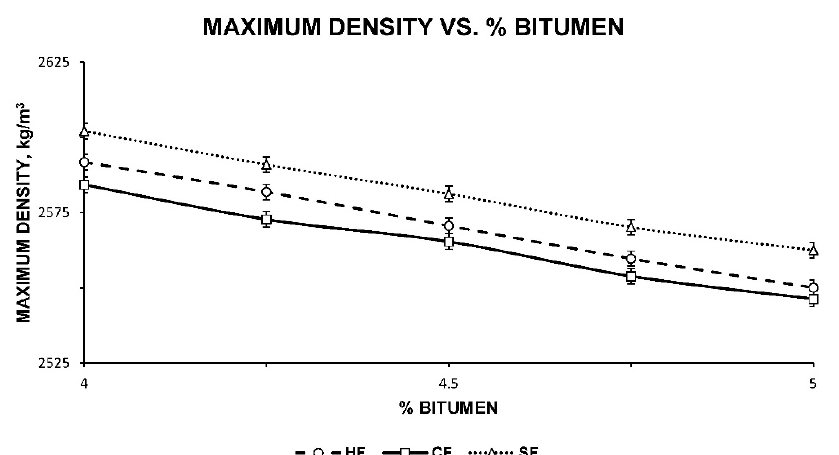
Figure 6. Maximum density of the HF, CF and SF families of bituminous mixtures according to the percentage of bitumen.